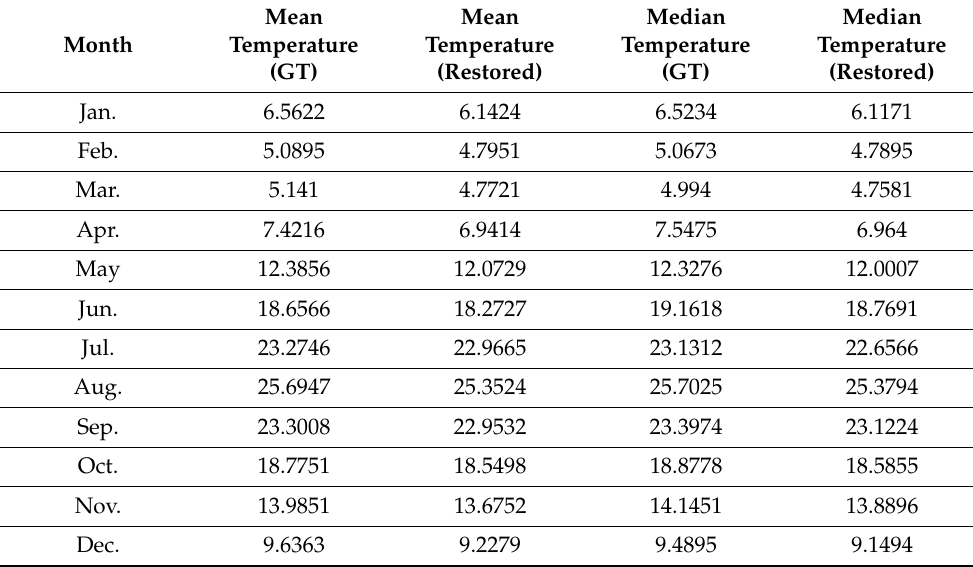
Table 4. Mean and median temperature ( ◦ C) of ground-truth and restored images for each month.